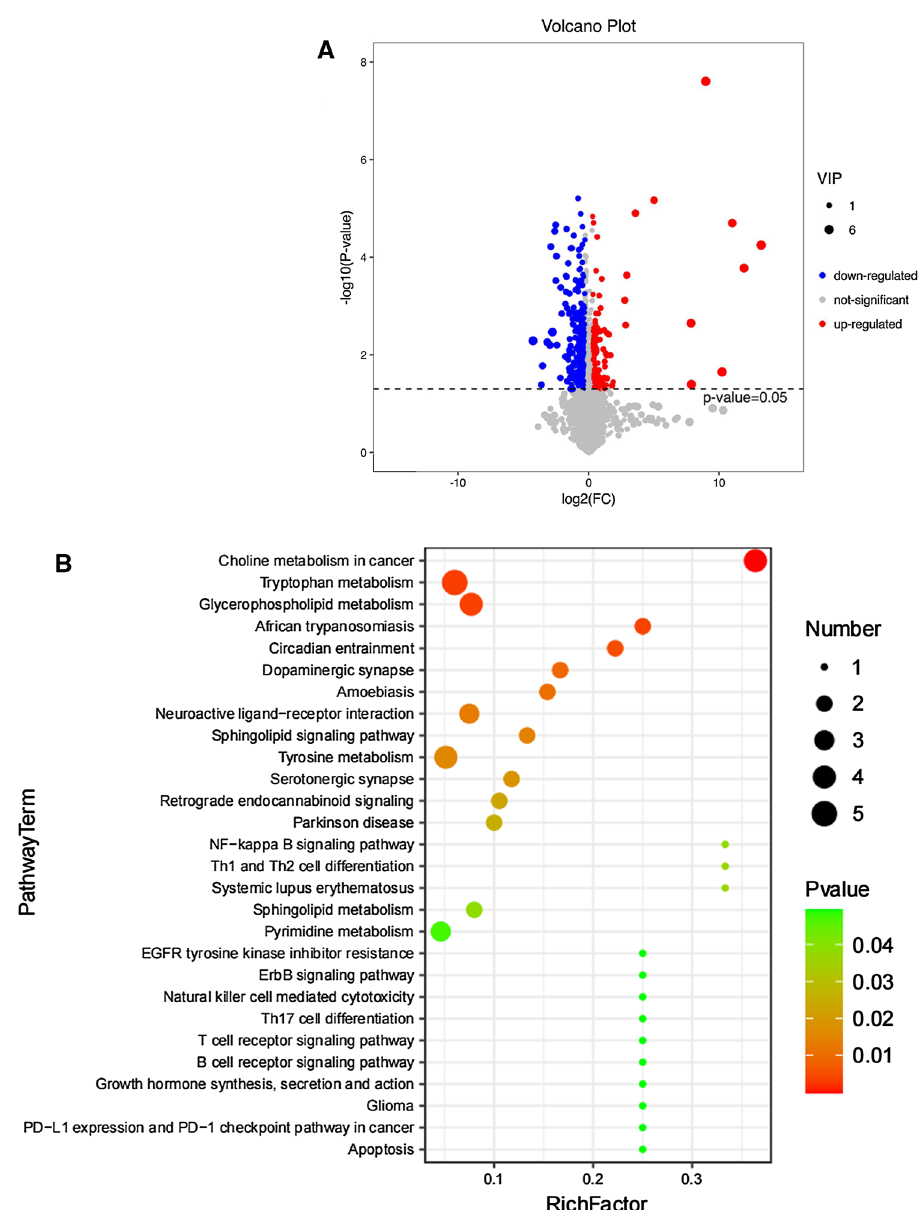
Fig. 6 Volcano map of dif- ferential metabolites and KEGG pathway enrichment analysis based on the LC–MS metabolomics assay. A The volcano map displayed 122 up-regulated metabolites and 245 down-regulated metabo- lites in SBI-115-treated-group when compared with the DMSO-treated group. The blue and red dots represented the significantly down-regulated and up-regulated metabolites in SBI-115-treated-group, respectively; B The KEGG pathway enrichment analysis was expressed as a bub- ble diagram. The size of the each bubble indicated the number of metabolites. The color of bubbles represented different P values. KEGG Kyoto Encyclopedia of Genes and Genomes, LC–MS liquid chro- matography–mass spectrom- etry, DMSO dimethyl